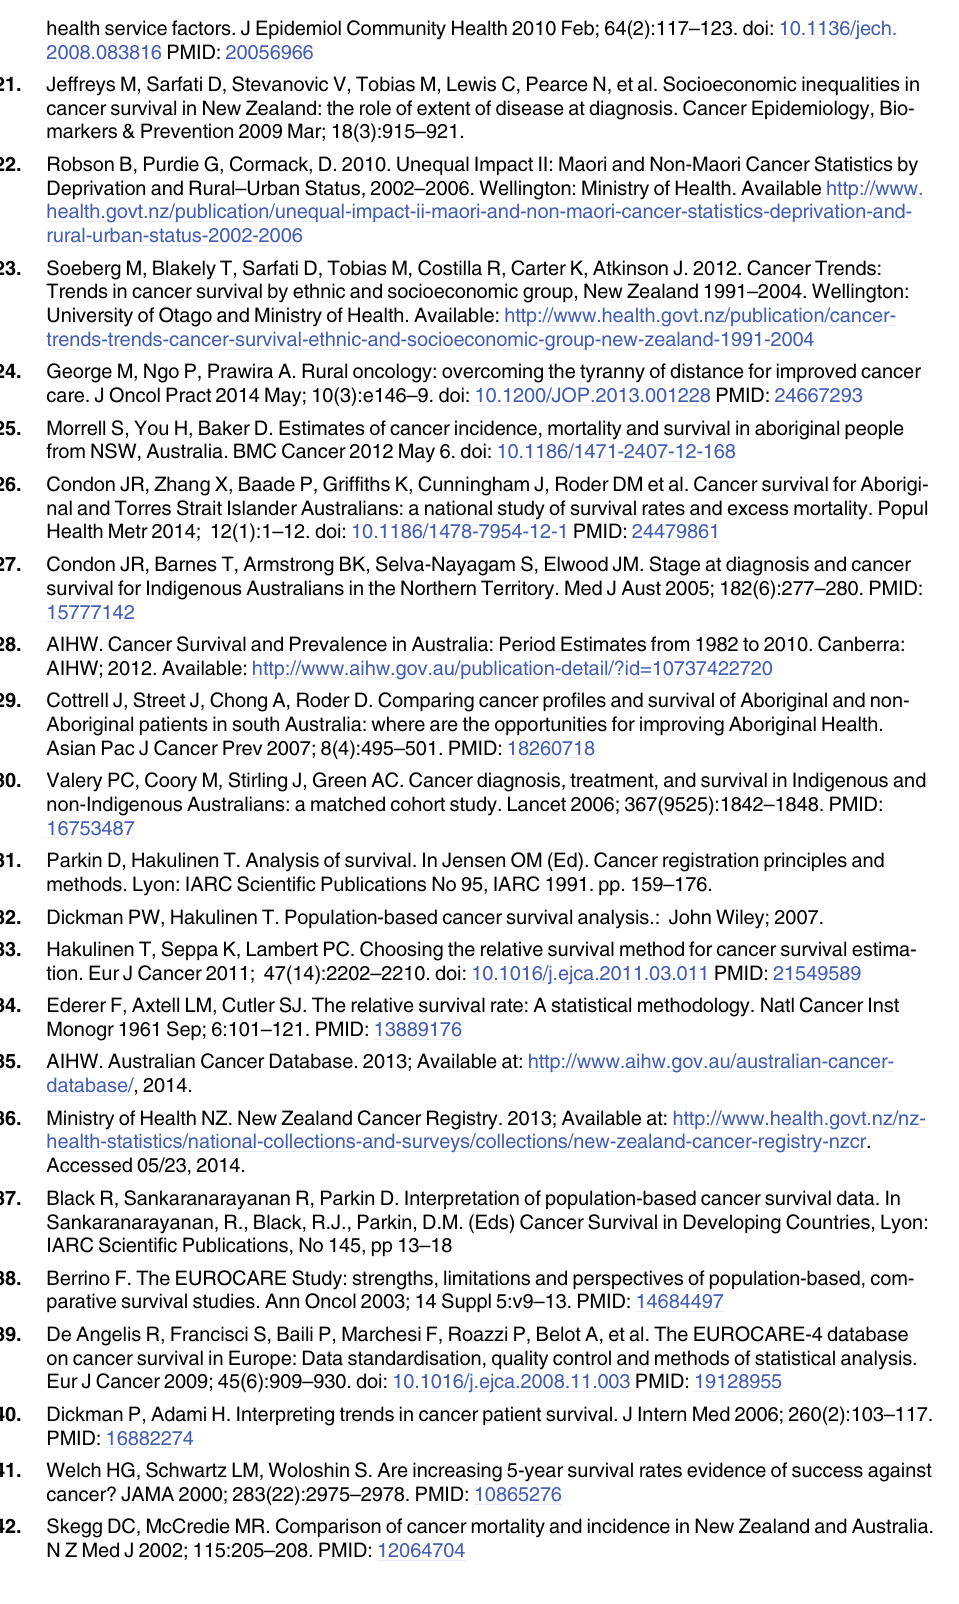
PLOS ONE | DOI:10.1371/journal.pone.0150734 March 3,